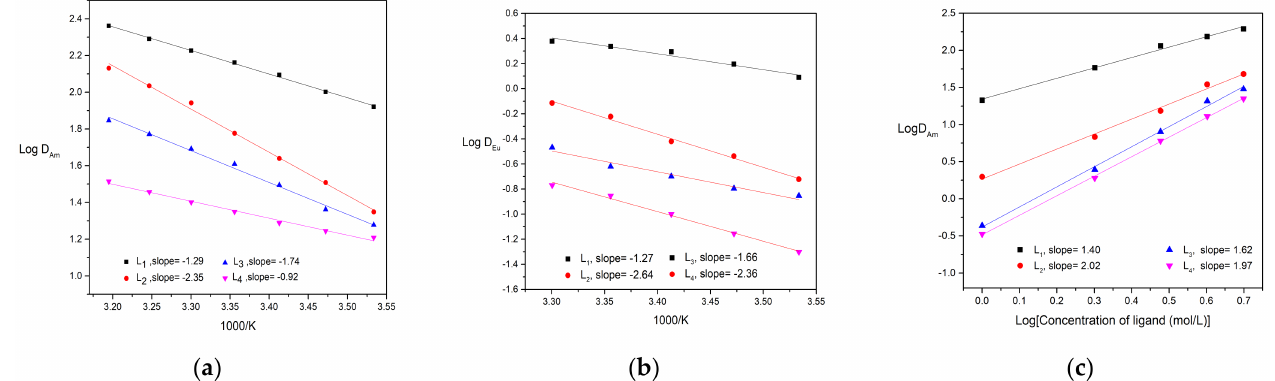
Figure 3. Extraction results of Am and Eu–dependence of Am(lll) and Eu(lll) distribution ratios on extraction temperature and ligand concentration: ( a ) Description of dependence of Am(lll) on extraction temperature. Organic phase: 5 mmol/L BTPhen/n–octanol; Aqueous phase: trace amount of 241 Am in 1 mol/L HNO 3 solution (Temperature, 298 ± 0.1 K; Contact time, 20 min); ( b ) Description of dependence of Eu(lll) distribution ratios on extraction temperature. Organic phase: 5 mmol/L BTPhen/n–octanol; Aqueous phase: 0.1 mmol/L Eu(NO 3 ) 3 in 1 mol/L HNO 3 solution. (Temperature, 298 ± 0.1 K; Contact time, 60 min); ( c ): Description of influence of ligand concentration on the extraction of Am(lll). Organic phase: 1–5 mmol/L BTPhen/n–octanol; Aqueous phase: trace amount of 241 Am in 1 mol/L HNO 3 solution (Temperature, 298 ± 0.1 K; Contact time, 20